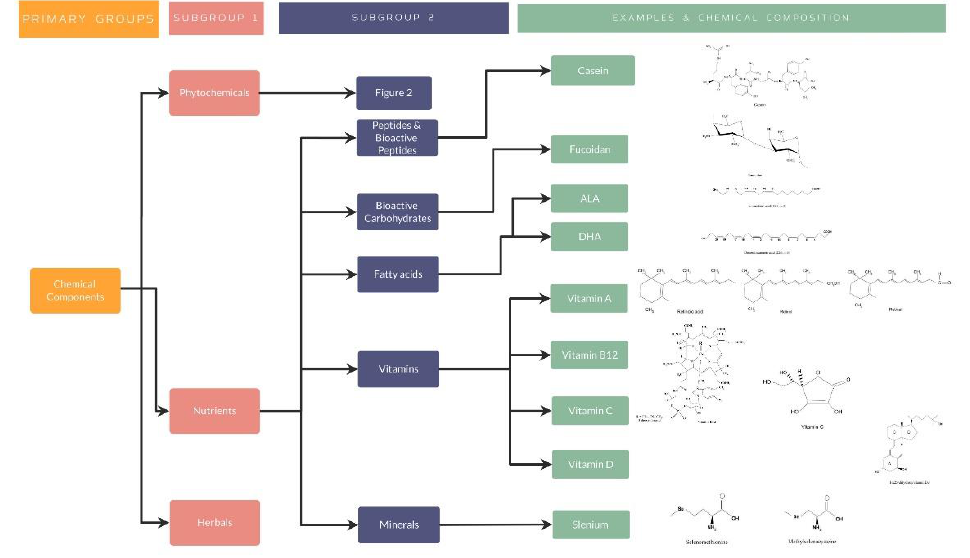
Figure 3. Nutrients classification, examples, and chemical composition.